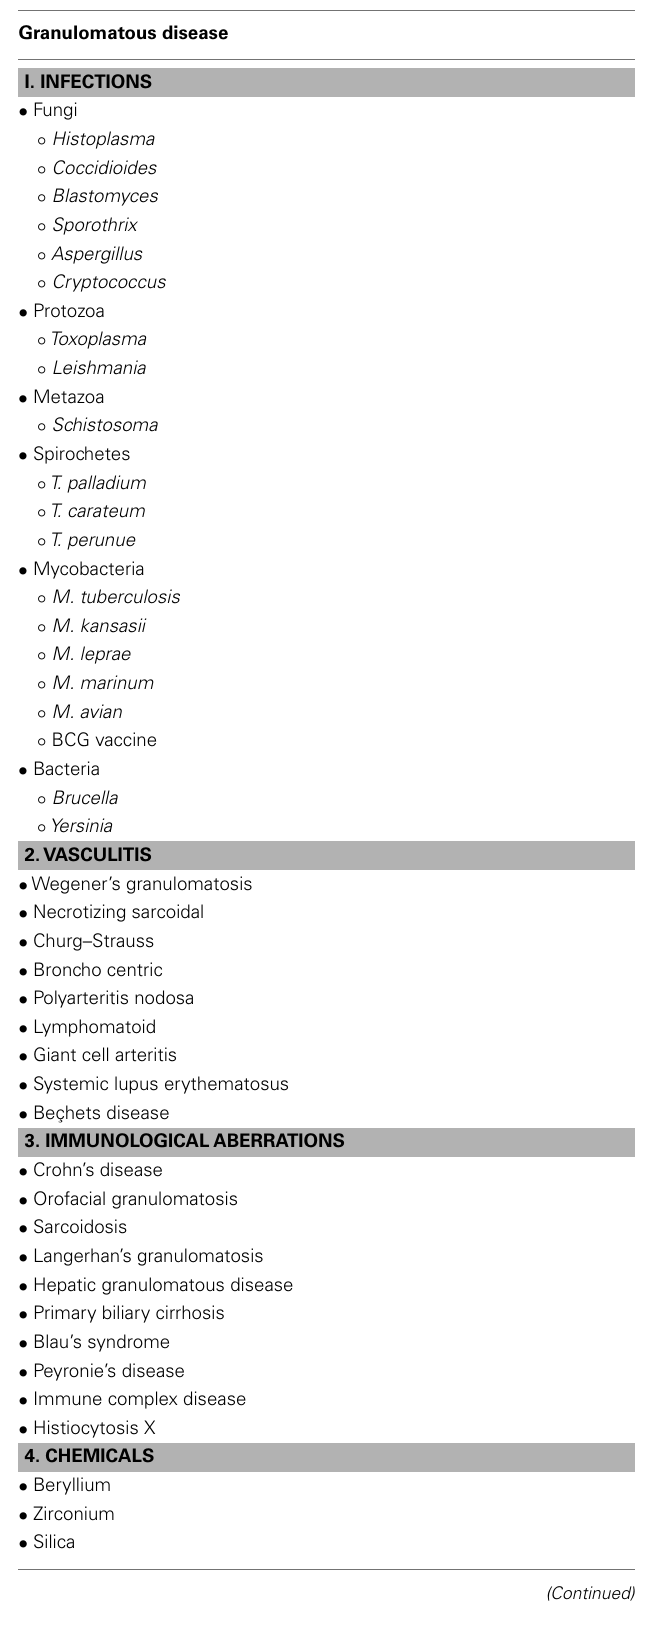
Table 1 |Table of granulomatous disorders. Granulomatous